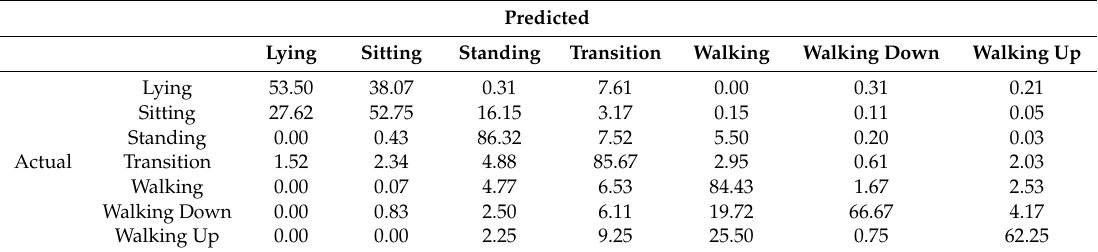
Table A9. Confusion matrix for the multichannel CNN-LSTM (in percentages, averaged over 10 runs). Predicted Lying Sitting Standing Transition Walking Walking Down Walking Up